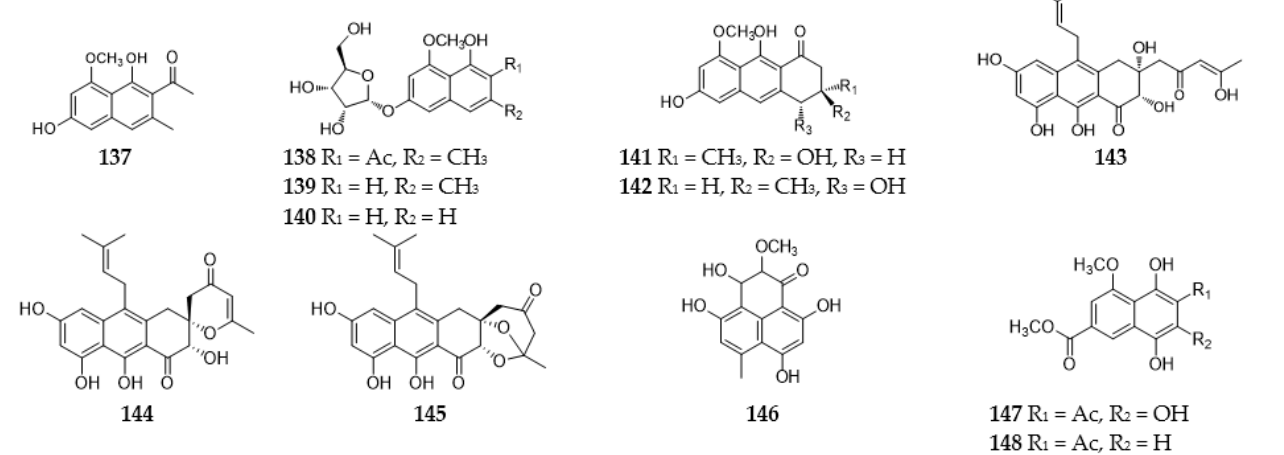
Figure 9. Aspergillus -derived naphthalenes ( 137 – 148 ).